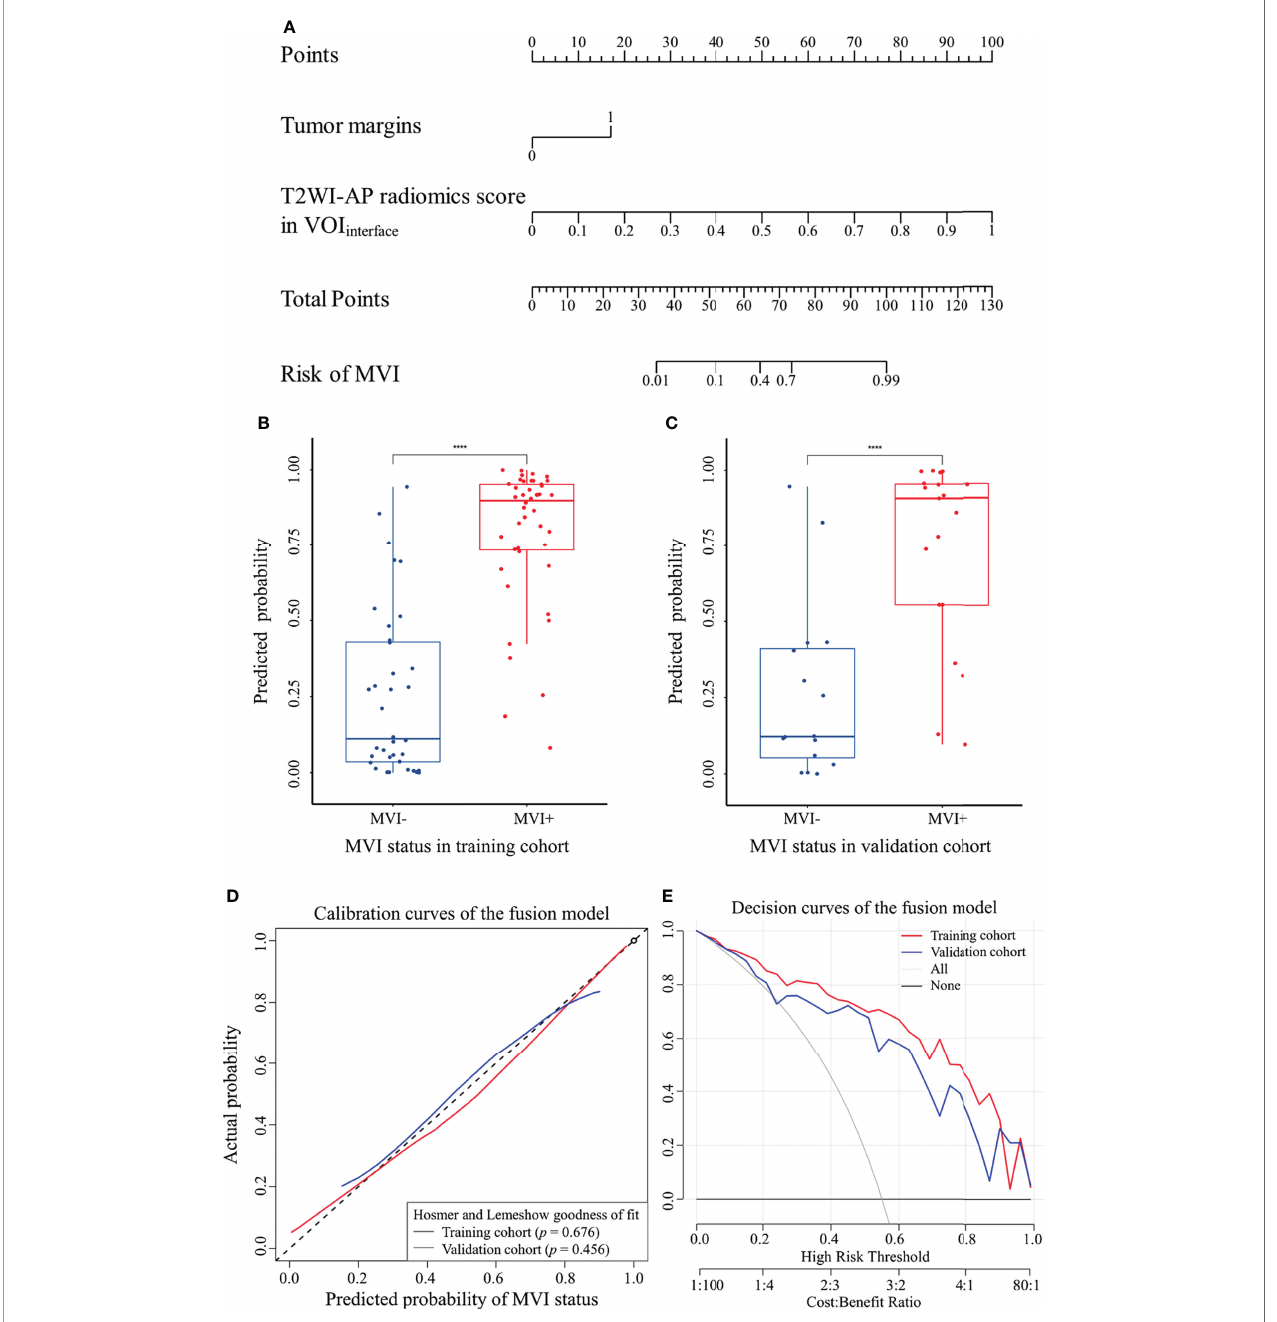
FIGURE 5 | The fusion model of MVI was visualized as nomogram. (A) MVI nomogram; (B) and (C) box plot of MVI risk probabilities in the training cohort and validation cohort, **** p < 0.0001 by Mann – Whitney U test; (D) calibration curves; (E) decision